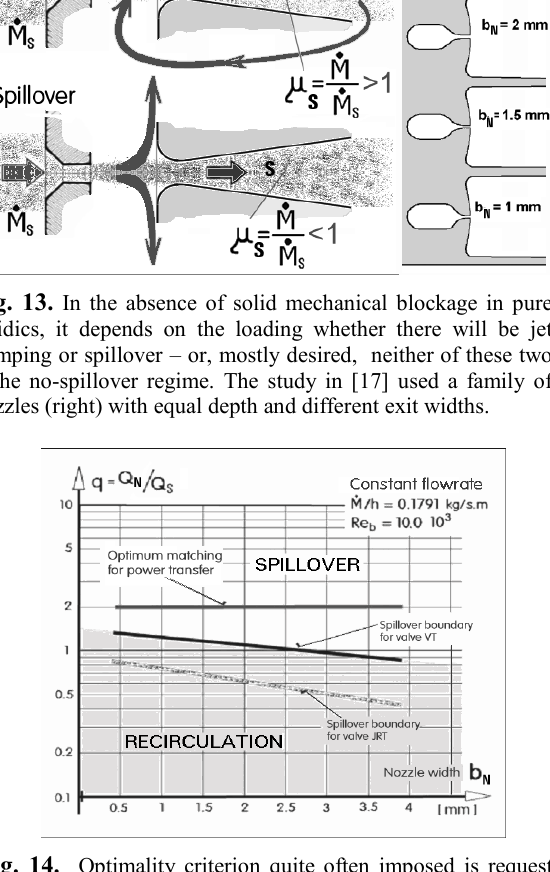
Fig. 14. Optimality criterion quite often imposed is request for the no-spillover regime. In this example from [17], various nozzles were connected to fluidic valve VT and JRT designs . Note that achieving the no-spillover  S = 1 was in both cases incompatible with the power transfer optimum q= 2 of Fig. 12.